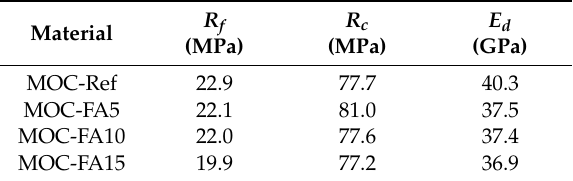
Table 5. Mechanical parameters of developed